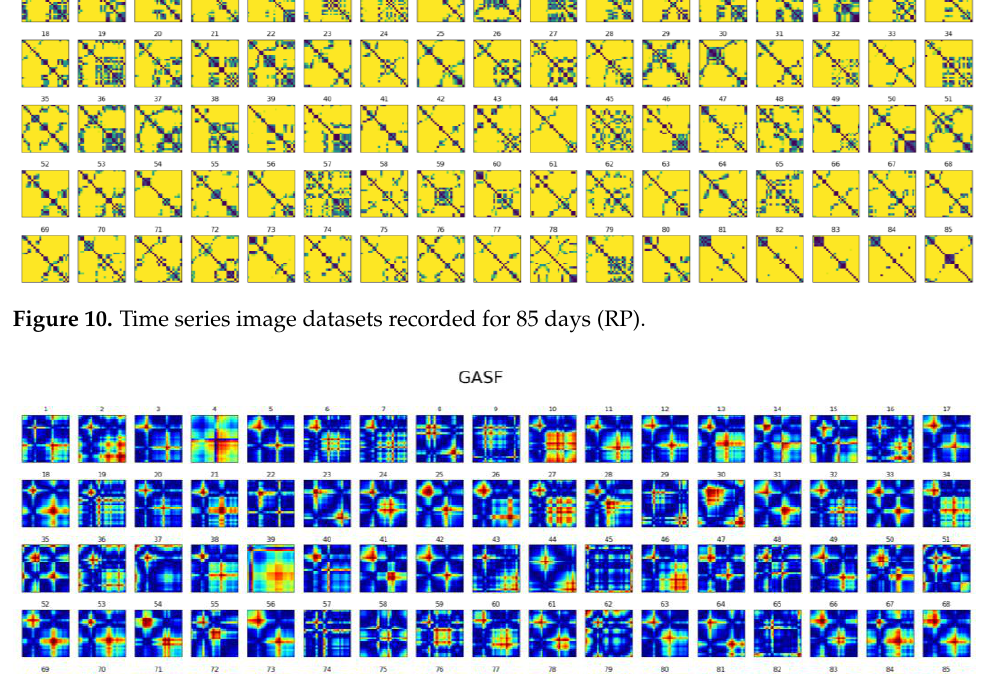
Figure 12. Time series image datasets recorded for 85 days (GADF). Figure 13. Proposed detecting anomaly method using time series images (MTF). 3.6. Using CNN-Based Model for Detecting Anomalies Although CNN is mainly used for object (defect, forgery, etc.) detection or image analysis, in this experiment [40,41], a convolutional neural network was used for binary classification of image datasets generated using four algor ithms. The neural network structure for binary classification is specified in Table 2. Since the shape of the image data used in this experiment was (24 and 24), the dimensions of the input data were set to (1, 24, 24). A neural network was constructed to determine whether the input image data were an anomaly through the neural network and to calculate a value close to 1 if normal and 0 if anomaly. After constructing two convolutional layers, a fully connected layer was placed for binary classification. The epoch was set to 50 to ensure sufficient learning. For the label for learning, the label constructed in the preprocessing stage of injecting anomaly